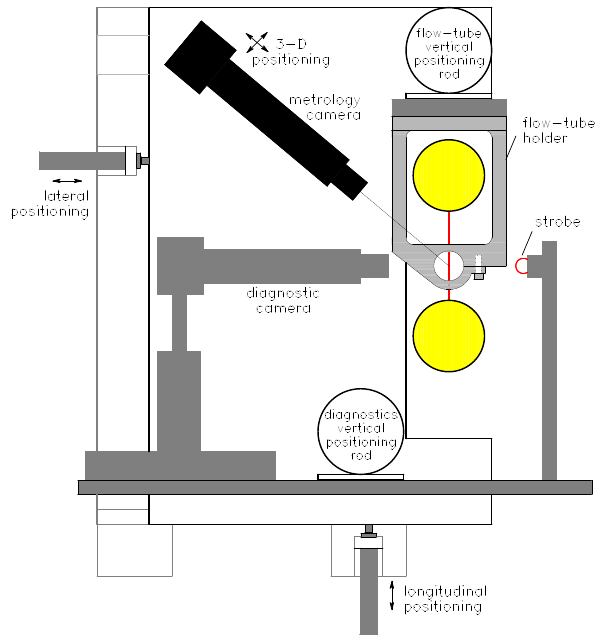
Fig. 3. Schematic of the calibration system, as viewed from above, illustrating the lateral and longitudinal directions. Yellow circles indicate the two arms of the CDP and the red line indicates the CDP laser